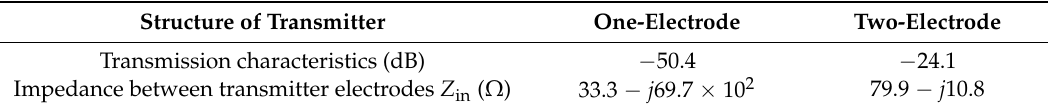
Table 1. Transmission characteristics and input